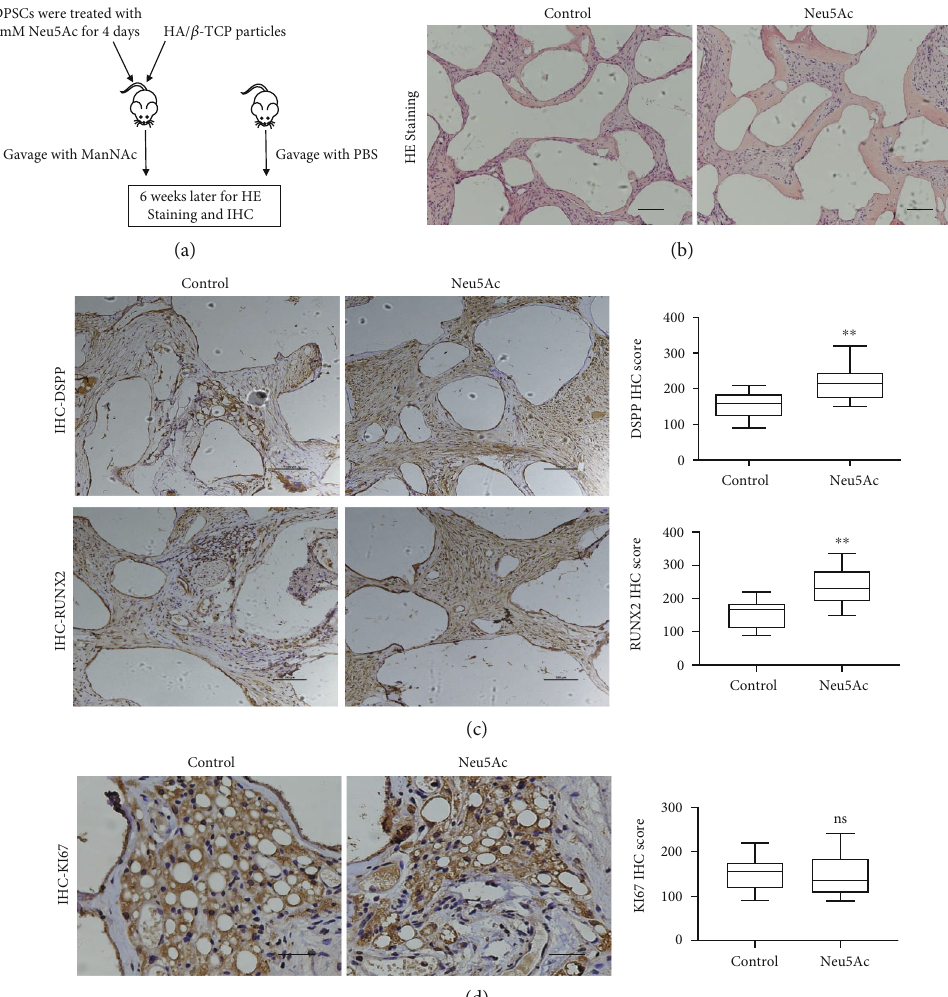
Figure 4: The method and impact of the ManNAc on DPSCs in vivo . (a) Flow chart of in vivo ectopic osteogenesis of DPSCs. (b) Hematoxylin and eosin stain showed enhanced osteogenesis in the ManNAc group than in the control group. (c, d) Immunohistochemistry and statistical analysis of the average H -score showed the e ff ect of ManNAc on proliferation and di ff erentiation of DPSCs. Scale bar = 100 μ m, ∗∗ p < 0 : 01 . All the experiments were repeated at least three times